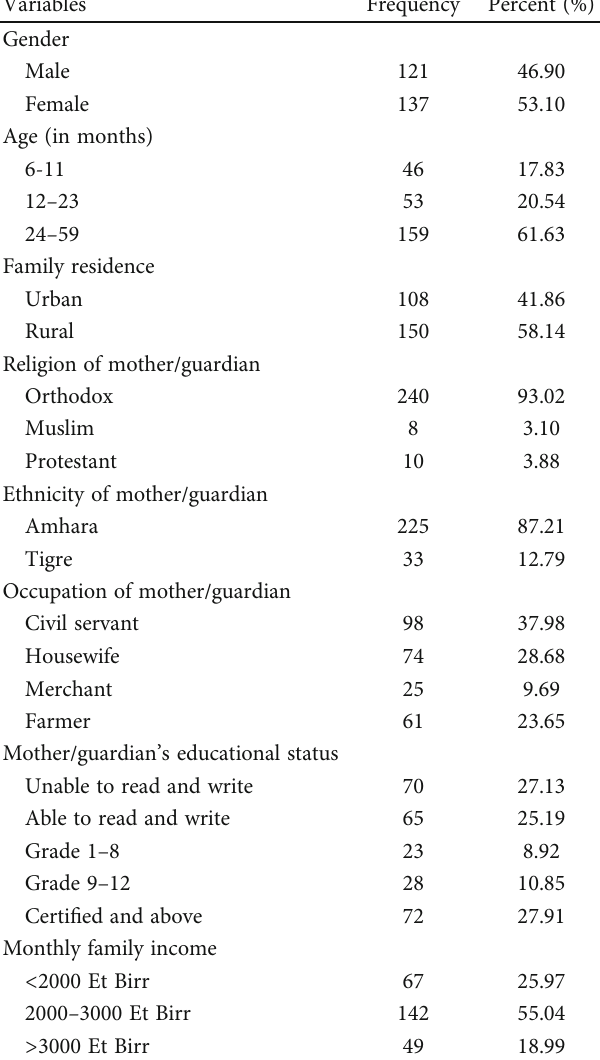
Table 1: Sociodemographic characteristics of under- fi ve children and their caregivers in Debre Tabor comprehensive specialized hospital, Northwest Ethiopia, 2021 (n